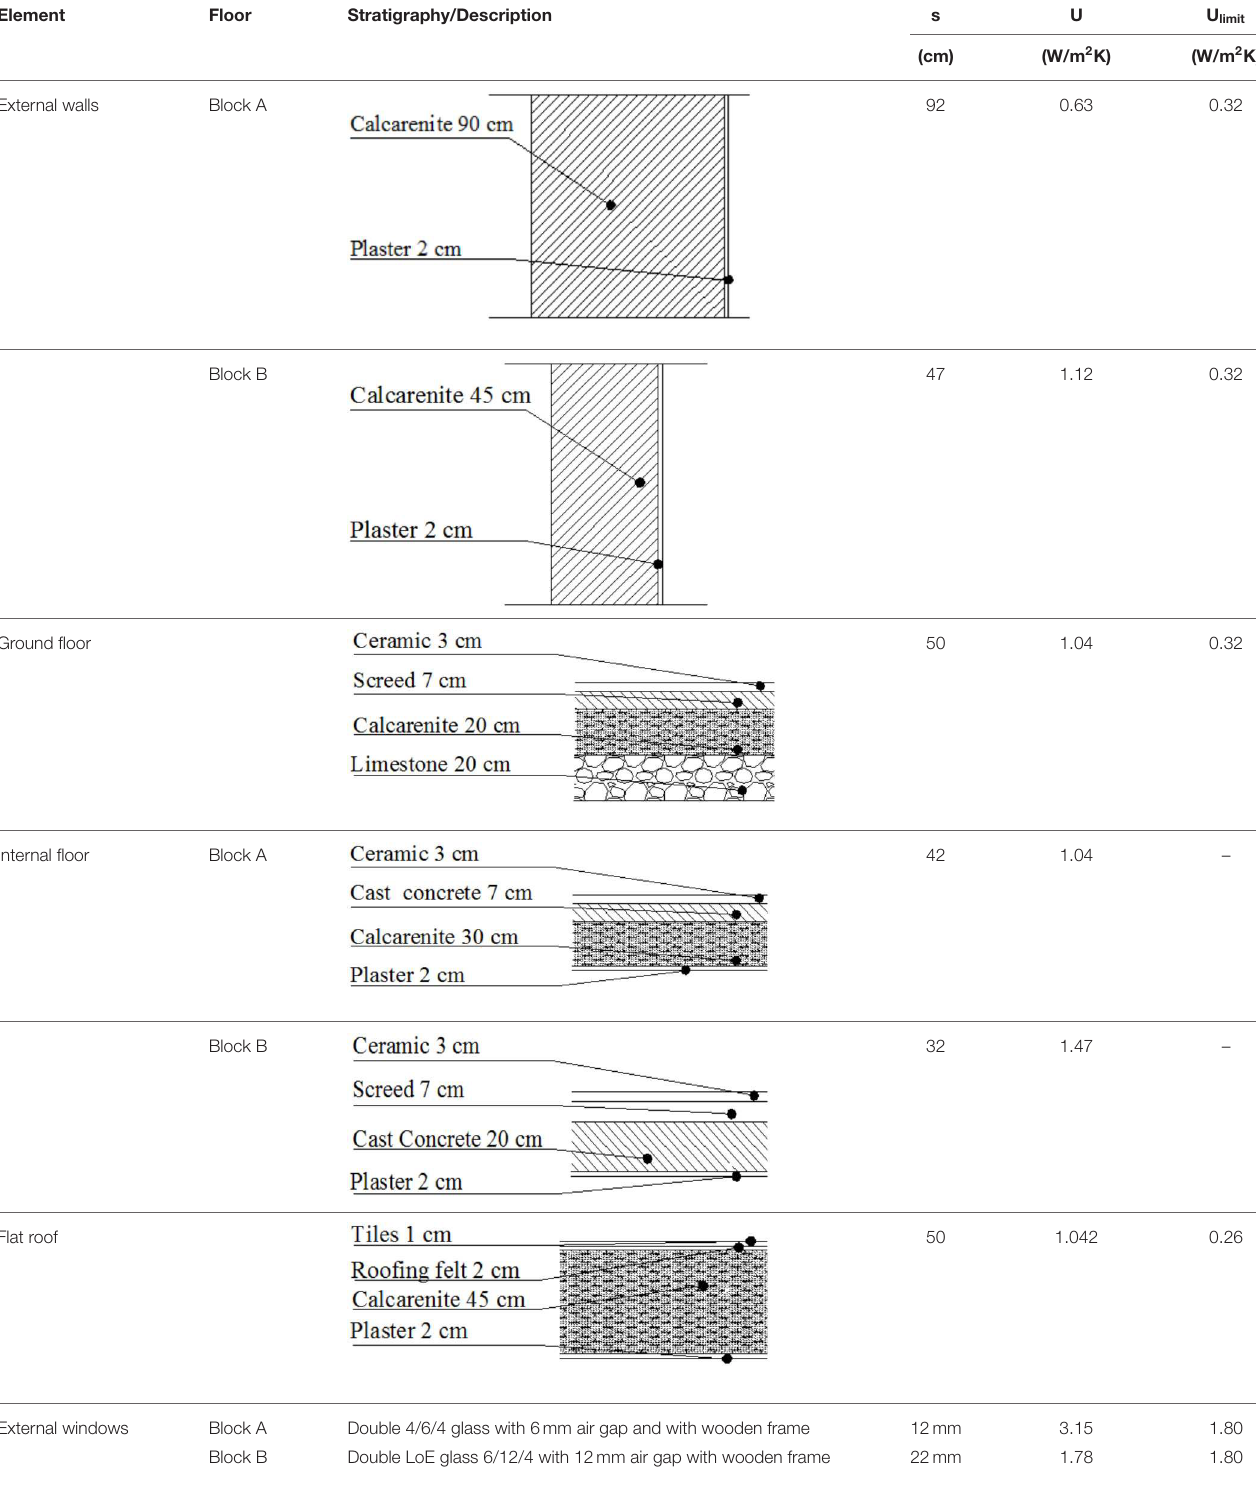
TABLE 2 | Transmittance of opaque and transparent elements.